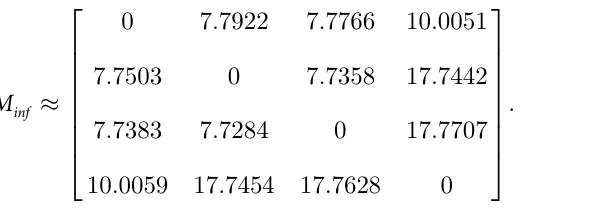
Algorithm 1: Monte Carlo estimation of M